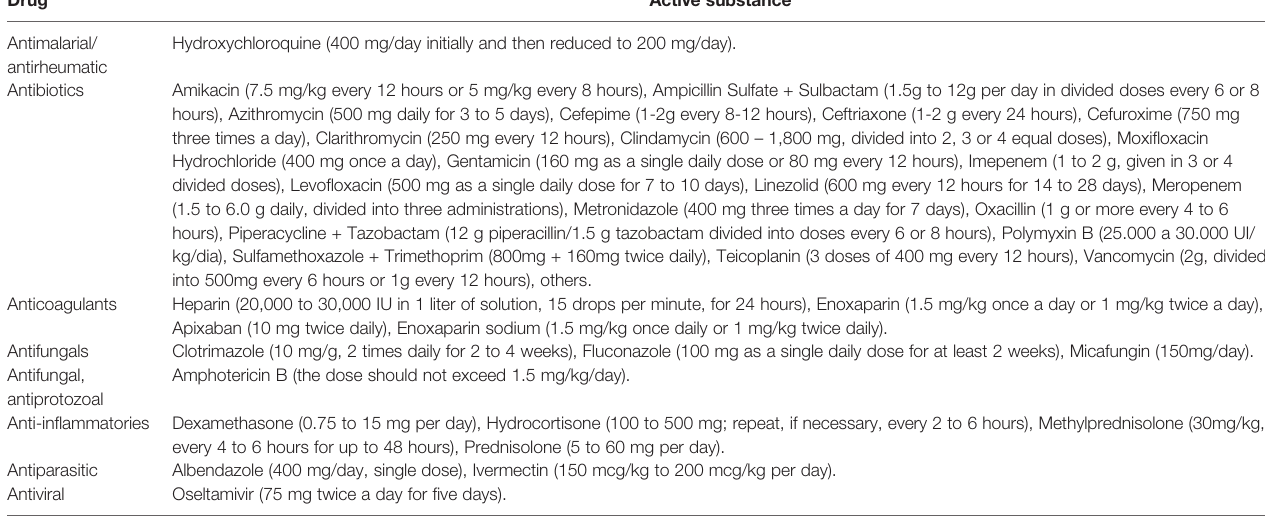
TABLE 1 | List of drugs administered to patients before and/or after